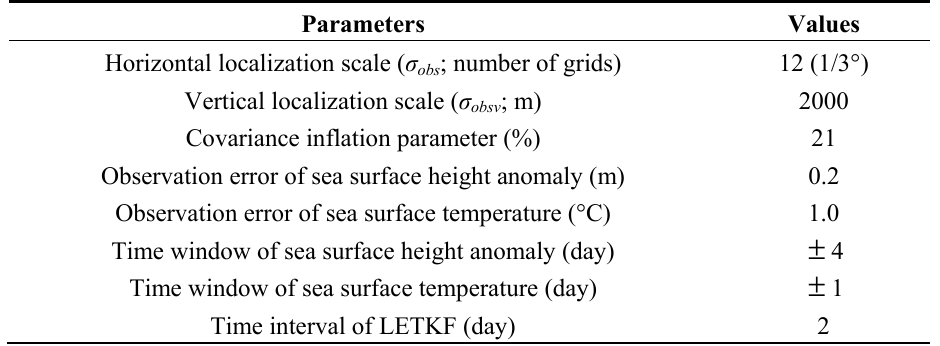
Table 1. Parameters used in Local Ensemble Transformation Kalman Filter